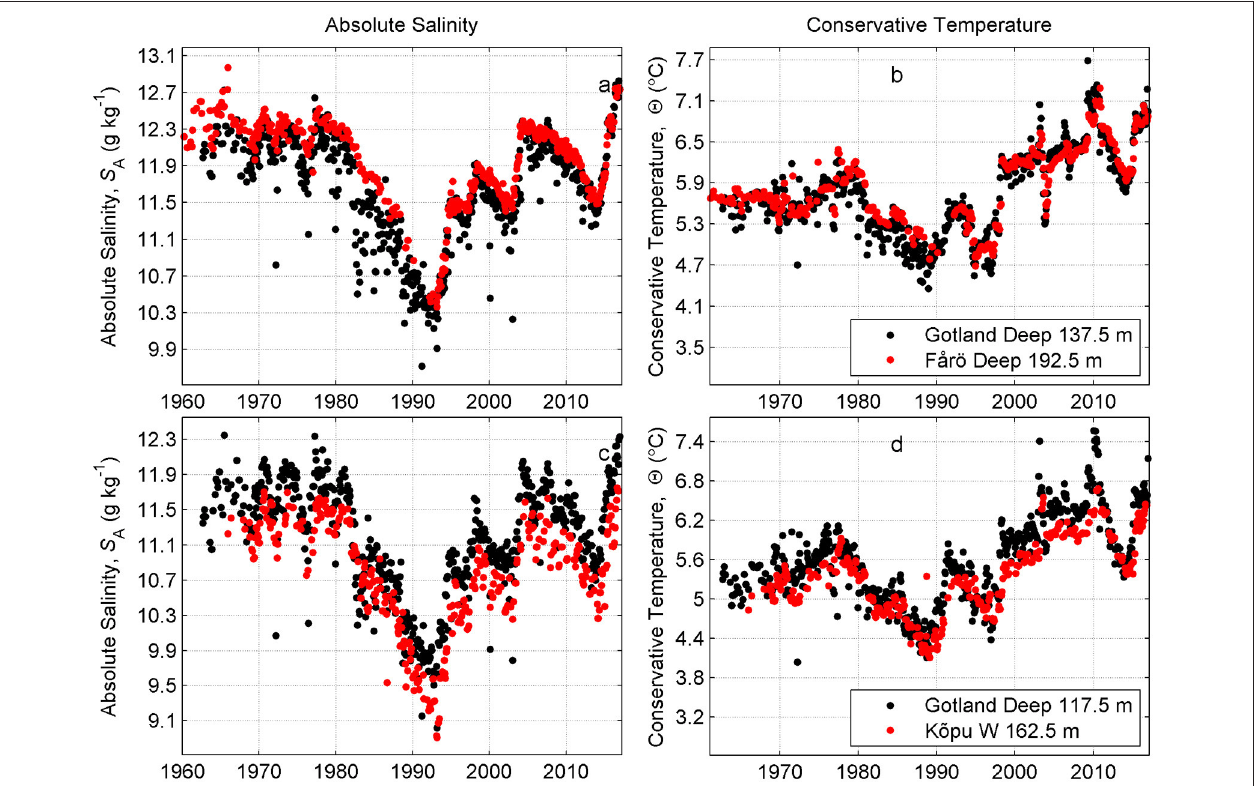
FIGURE 12 | Temporal course of monthly average salinity and temperature at the selected depths along the pathway Gotland Deep (a-d) , Fårö Deep (a, b) , and Kõpu West (c, d)